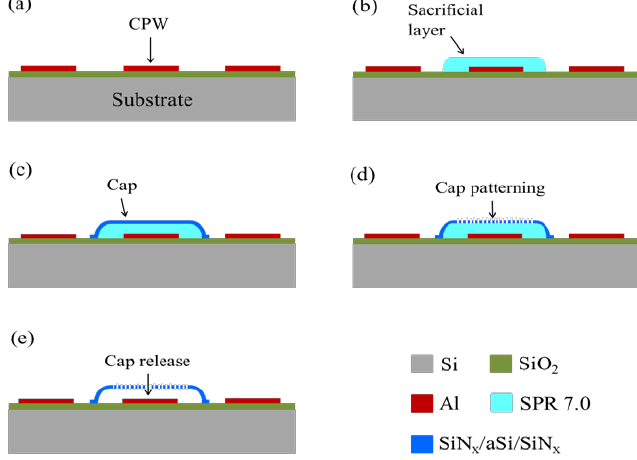
Figure 1. Sketch of the process flow for the fabrication of thin film encapsulating caps.